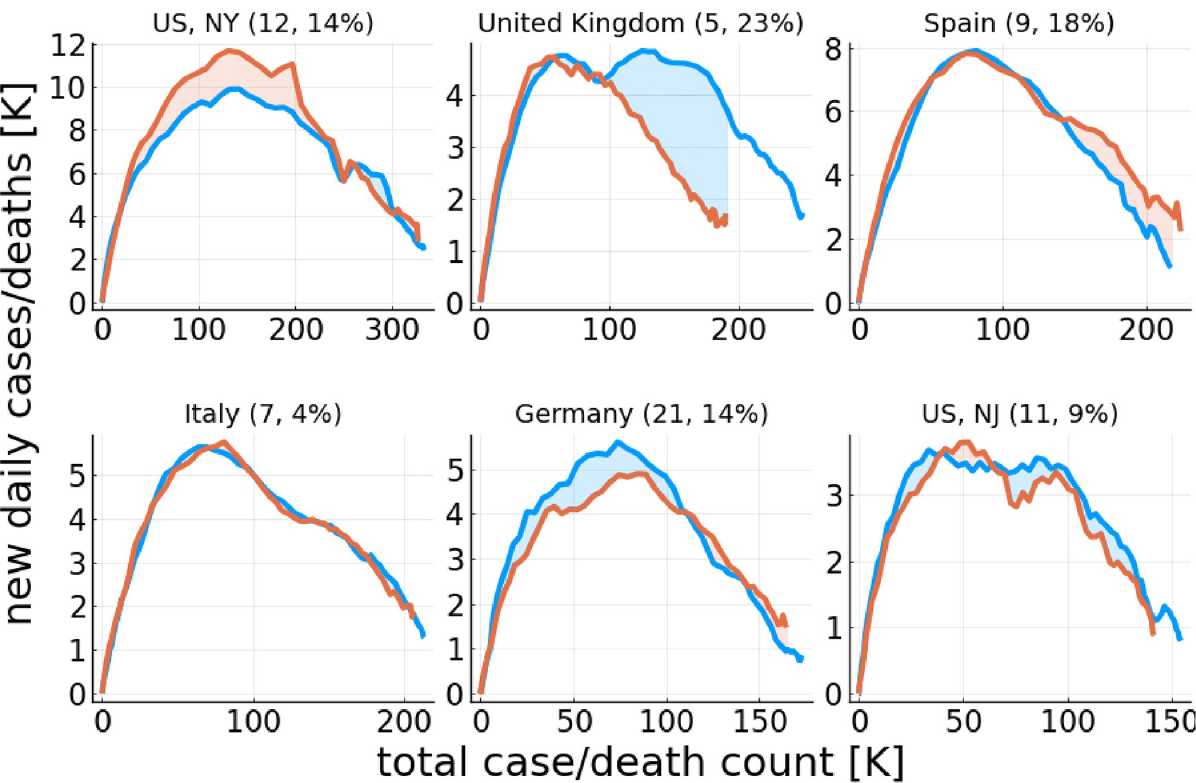
Fig 3. COVID-19 cases vs. fatalities. Daily new cases Δ X as a function of the total case count, X (blue), and the rescaled daily fatalities, Δ F ! f F Δ F , as a (orange). The rescaling factors f , given in brackets (first number), have been determined by aligning function of the rescaled total death count, F ! f F F F the initial slopes Δ F / F and Δ X / X . The accuracy of the rescaling, S F , measured as the relative area difference (shaded area over total area, see Eq (6)), is given in the brackets (second number). Shown are countries and regions with the highest cumulative fatality counts, out of the ones considered here, as listed in Table 1. The data has been terminated once Δ X has fallen by 70%, which we use to define the first outbreak.